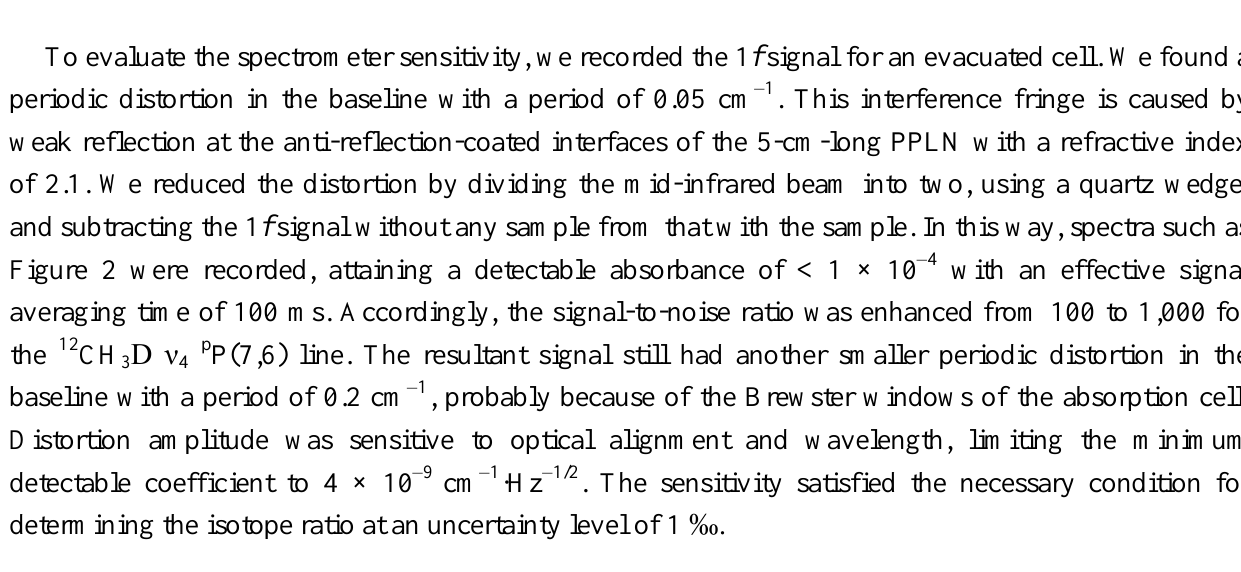
Figure 3. Pressure dependence of the signal ratio, R CH 3D = I 1fCH 3D /I 1fCH 4